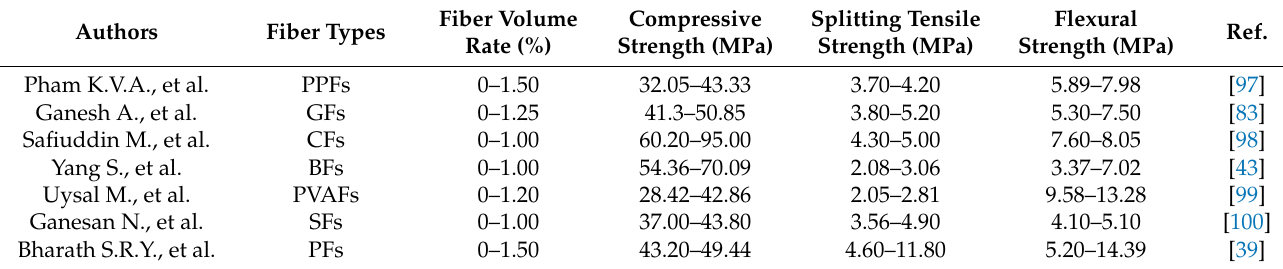
Table 6. The effect of fiber type on geopolymer concrete.